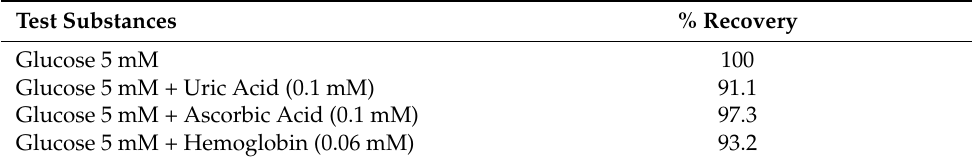
Table 3. Effects of interferences on the paper-based PB/Ti 3 C 2 T x